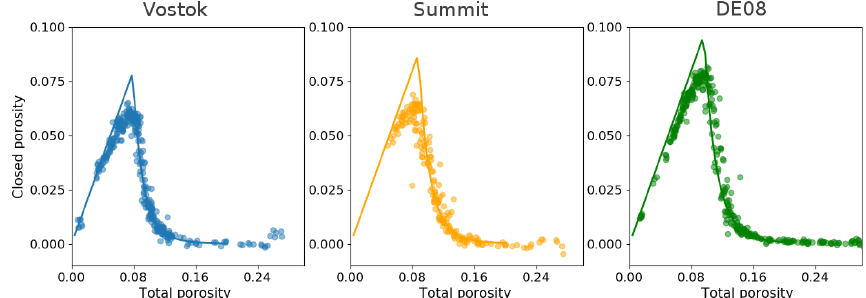
Figure 5. Measured closed porosity in the Vostok, Summit, and DE08-2 firn samples with the original processing chain. The corresponding Barnola parameterizations are displayed as solid